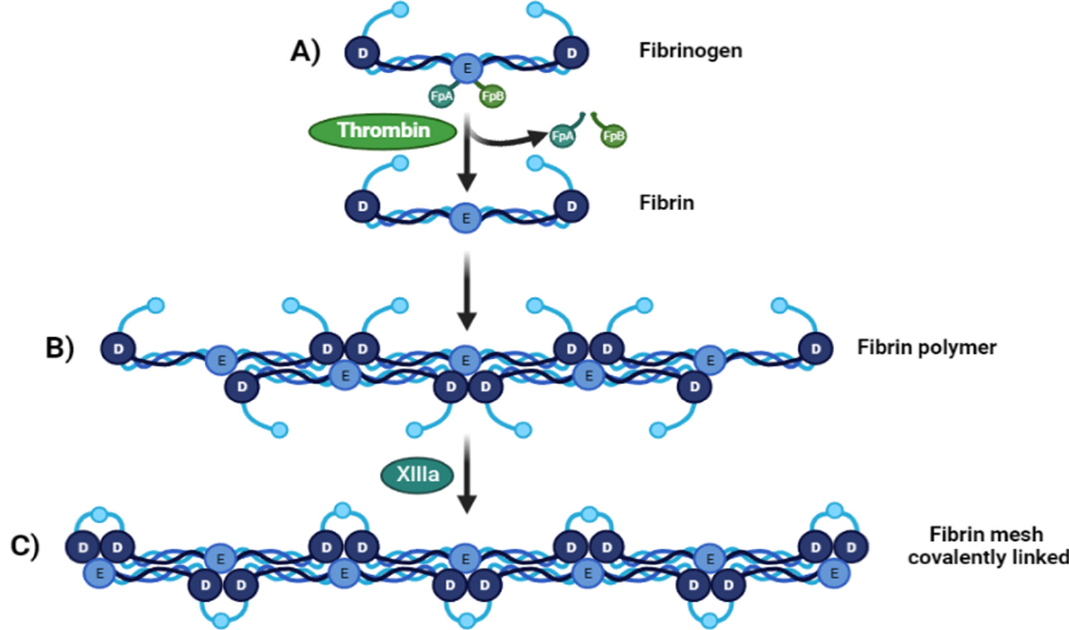
Figure 1. From fibrinogen to fibrin Mesh. ( A ) Fibrinogen D:E:D regions interact with thrombin- realizing fibrinopeptides (FpA and FpB) ( B ). Soluble fibrin is then activated by Factor XIIIa, permitting sulfide bonding to crosslink among fibrin, converting it to a ( C ) crosslinked fibrin poly- mer.